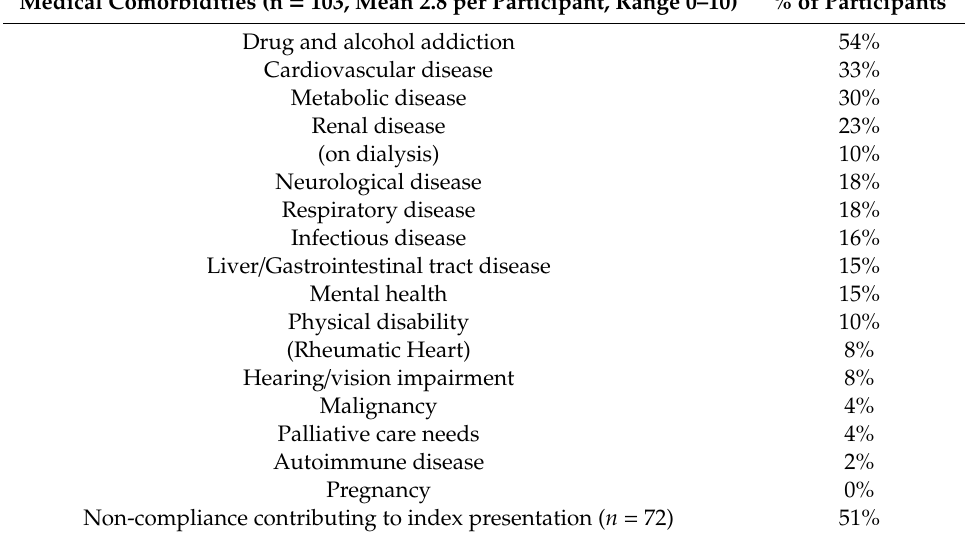
Table 3. Medical comorbidities.